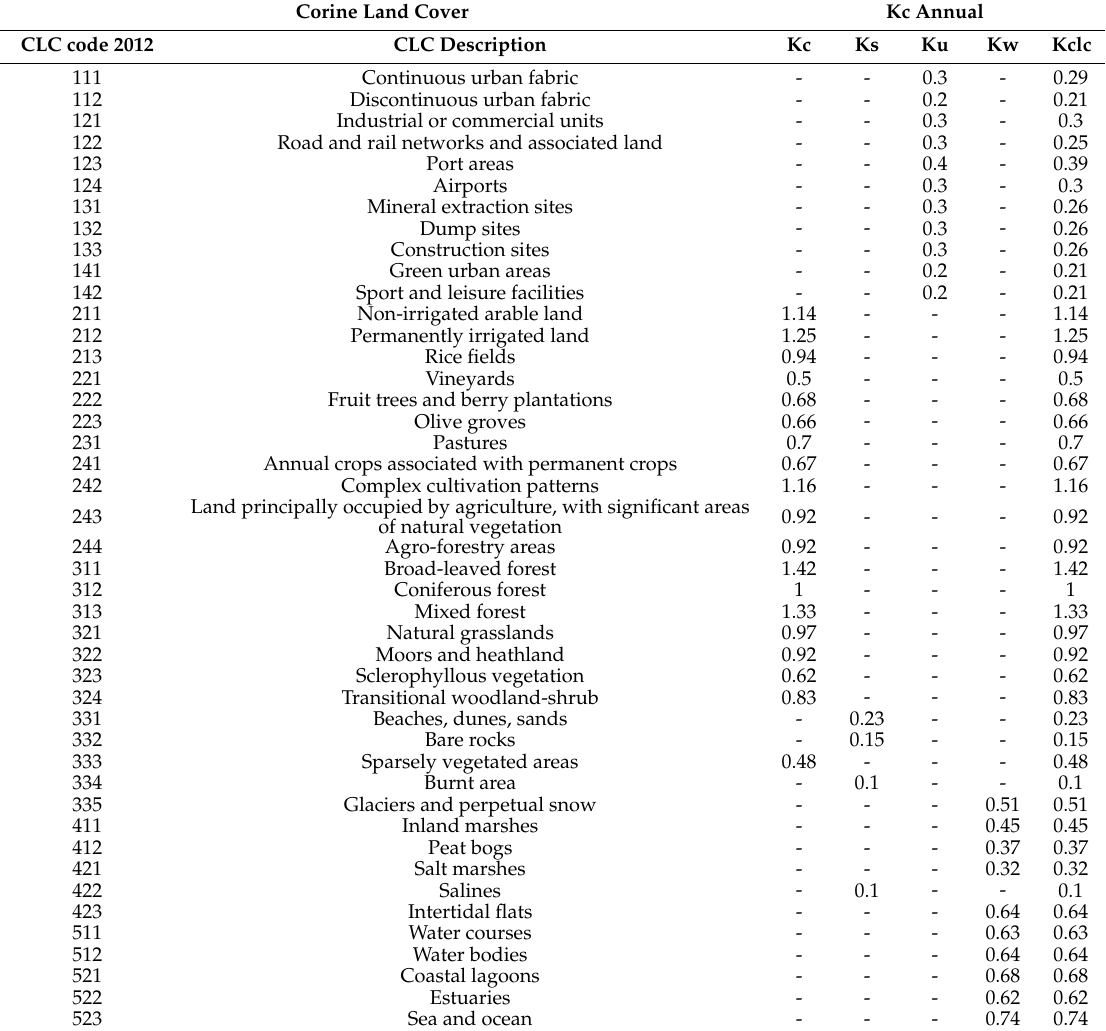
Table 4. Corine land cover classes and appropriate annual crop coe ffi cient (Kc) presently, in the Piedmont